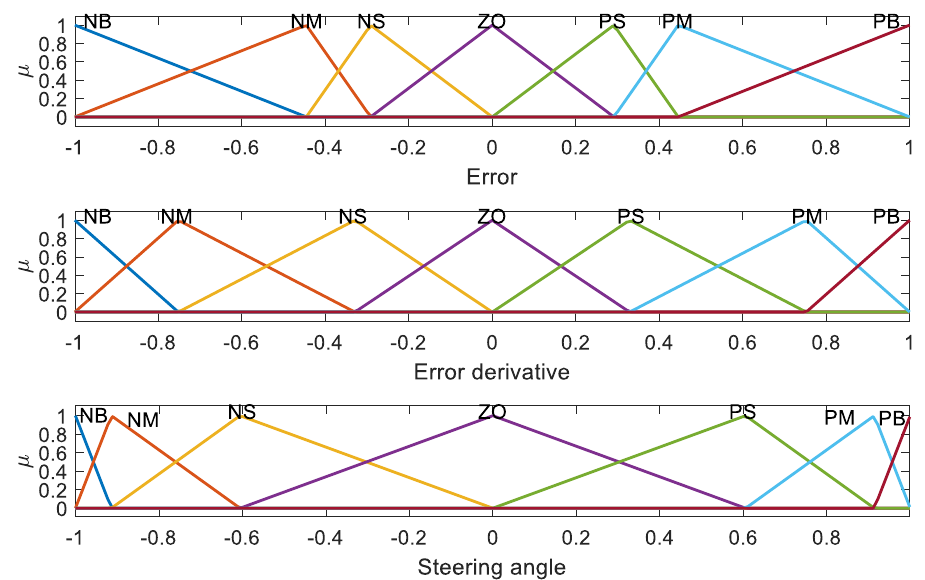
Figure 15. Optimized distribution of MFs.